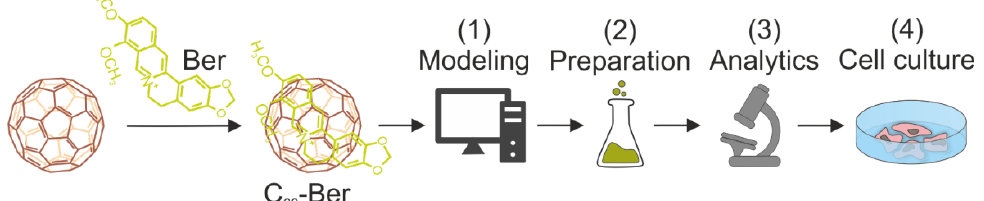
Figure 1. The workflow for the development of C 60 -based cancer chemotherapy with the use of Berberine (Ber): ( 1 ) computer modeling of the C 60 -Ber nanocomplex; ( 2 ) the fast and cost-effective preparation of nanocomplexes in different molar ratios in aqueous solutions; ( 3 ) the analytical assessment of nanocomplex stability to prove its biological applicability; ( 4 ) noncovalent complexation of aromatic Ber molecule with C 60 , improving its efficiency against human leukemic